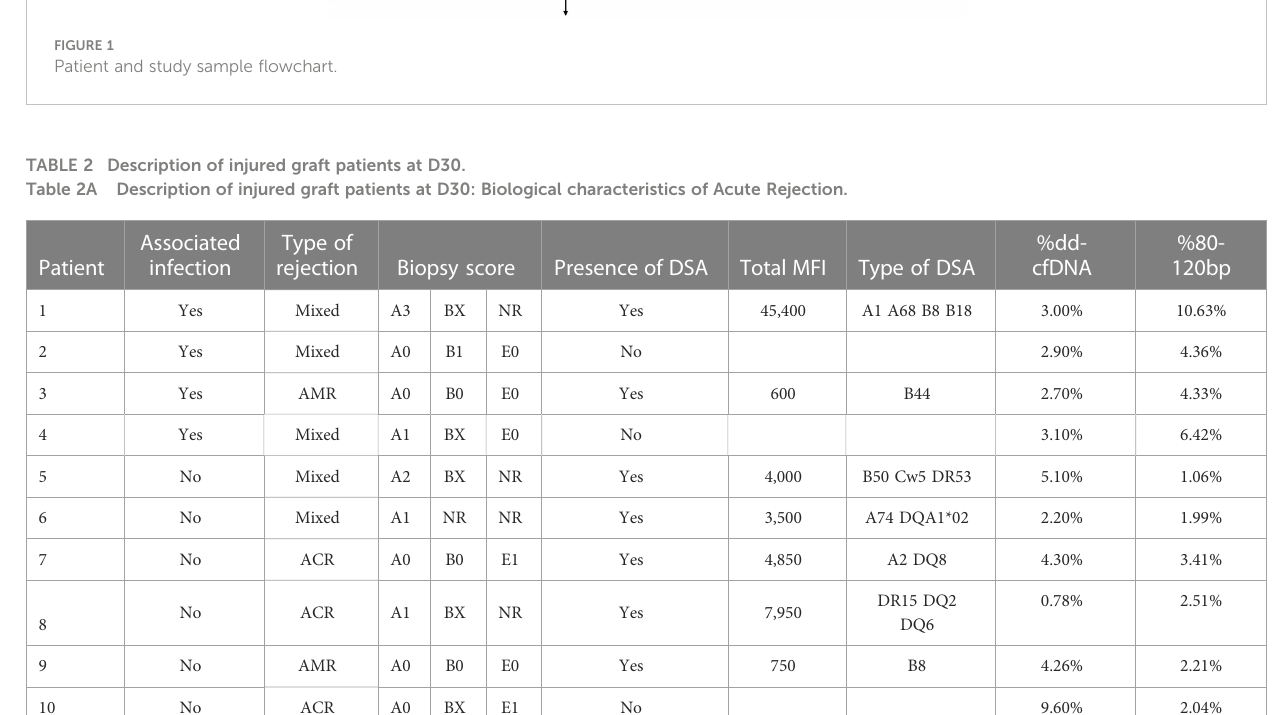
FIGURE 1 Patient and study sample fl owchart.